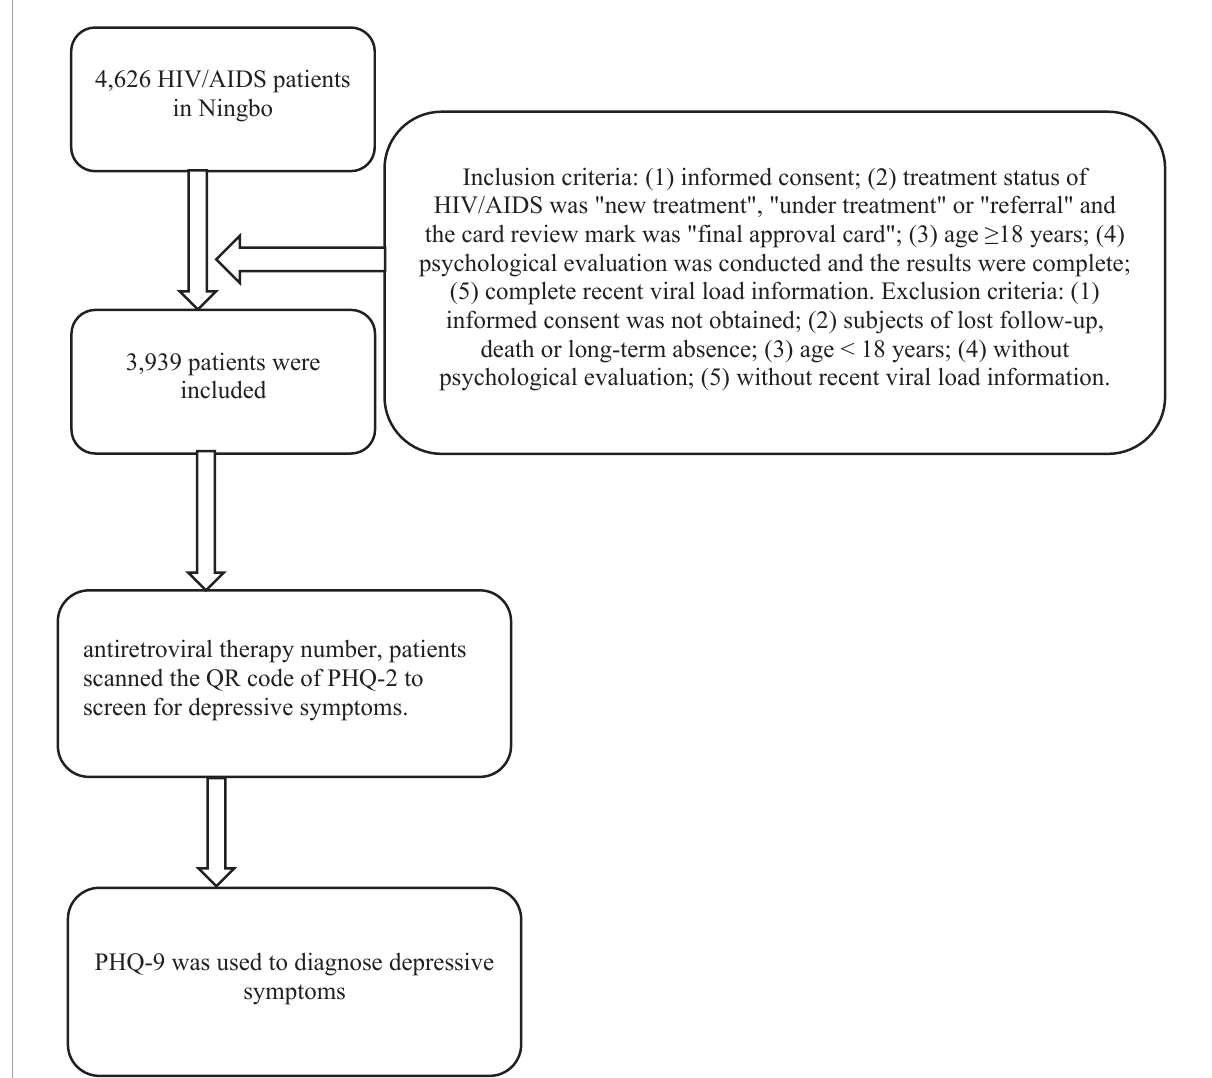
FIGURE1 Flowchart for the data